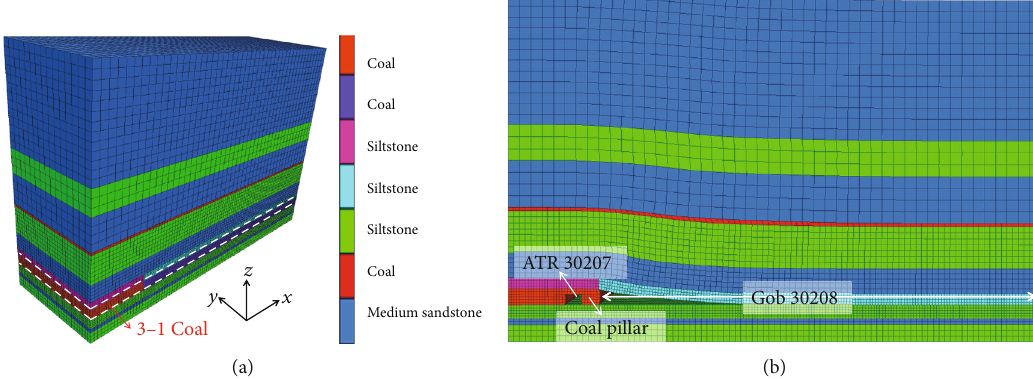
Figure 3: Numerical model establishment: (a) three dimensional view of the model and (b) model plan.